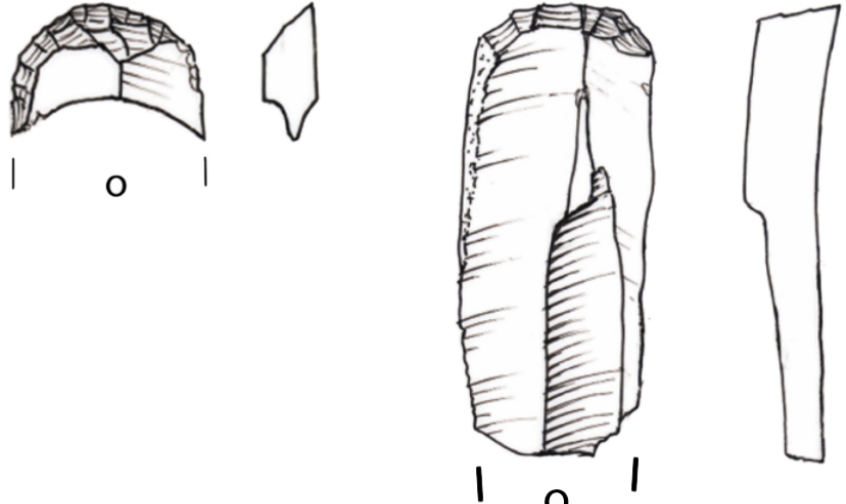
Figure 7. Two blade-scrapers from Nethermills Farm (left: CAT 78/123: length 9mm; right: CAT 79/404: length 40mm).